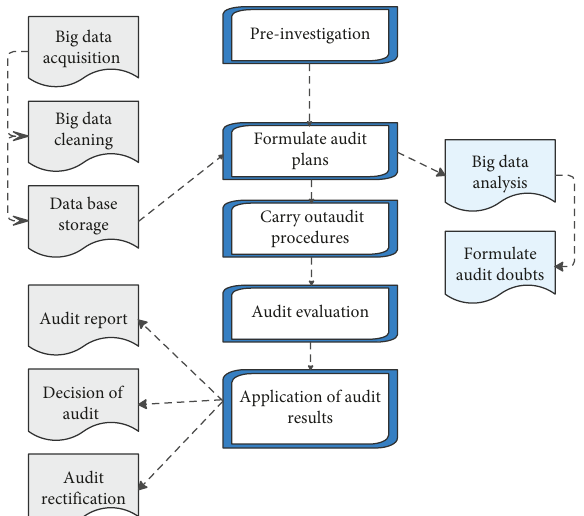
Figure 7: Big data internal control audit process framework. Table 1: Audit data mining